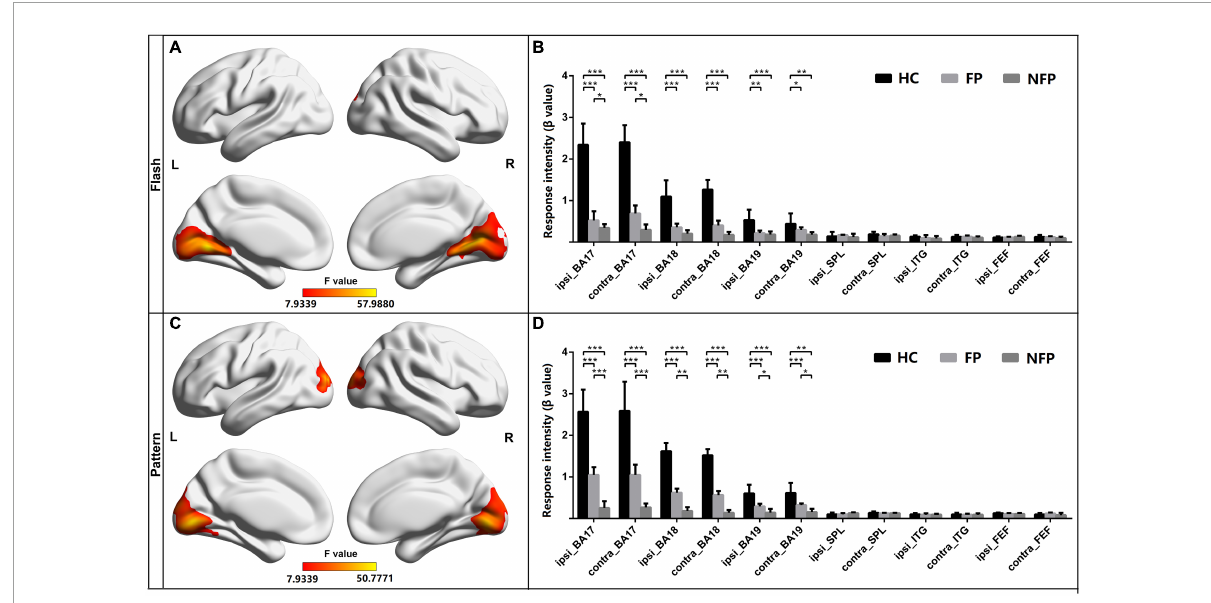
FIGURE4 Comparison of the response intensity of participants in the FP, NFP, and HC groups in the flash and pattern visual tasks. (A) Significant differences ( F -values) were observed in response intensity across brain areas for participants in the three groups in the flash visual task. (B) Comparison of the response intensity in Brodmann areas 17, 18, and 19 and in SPL, ITG, and FEF areas of participants in the three groups in the flash task. (C) Brain areas with significantly different response intensities in participants in the three groups in the pattern visual task. (D) Comparison of the intensity of the response in both Brodmann areas 17, 18, and 19 and in the SPL, ITG, and FEF areas to the pattern stimulus for participants in the three groups. HC, healthy control; FP, form perception; NFP, no form perception; ipsi_BA, ipsilateral Brodmann area; contral_BA, contralateral Brodmann area; ipsi_SPL, ipsilateral superior parietal lobule; contral_SPL, contralateral superior parietal lobule; ipsi_ITG, ipsilateral inferior temporal gyrus; contral_ITG, contralateral inferior temporal gyrus; ipsi_FEF, ipsilateral frontal eye field; contral_FEF, contralateral frontal eye field. *** P < 0.001, ** P < 0.01, and * P < 0.05.